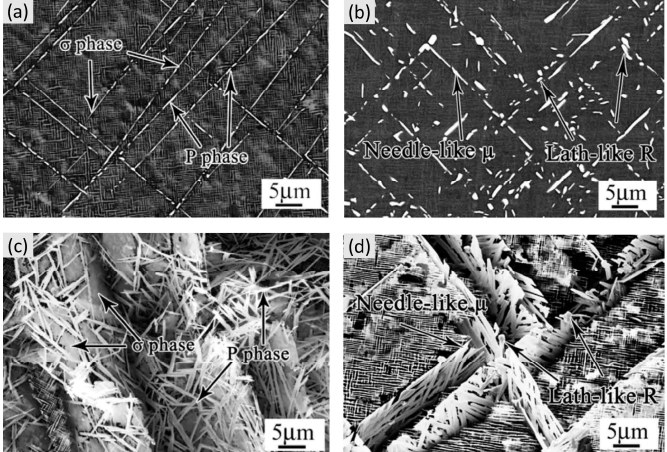
Figure 6. PSDs for Ni-A Typical TCP phases in Ni-based SX superalloys. ( a ) σ phase and P phase (2D-characterization); ( b ) μ phase and R phase (2D-characterization); ( c ) σ phase and P phase (3D-characterization); ( d ) μ phase and R phase (3D-characterization) [47,48].